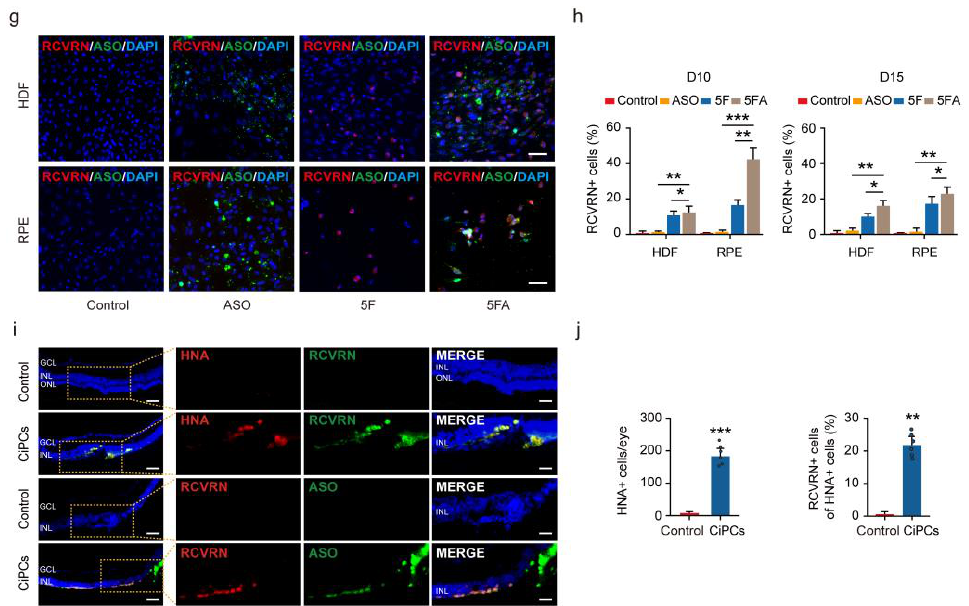
Figure 2. CiPCs induction is enhanced by suppression of PTBP1. ( a , b ) Bright-field images of HDF ( a ) and RPE cells ( b ) treated with PTBP1 ASO only or 5F plus ASO (5FA) at D3 and D10. Scale bars: 50 µ m. ( c ) Relative mRNA expression of PTBP1 after 5F or 5FA treatment at D3 and D10. n = four repetitions. Statistical comparison was performed by a two-tailed, unpaired t-test. ( d ) Western blot analysis showing that the expression of PTBP1 was significantly downregulated after 5FA treatment at D3 and D10. n = three repetitions. ( e , f ) Relative mRNA expression of photoreceptor- related genes in ASO only, 5F, and 5FA treated HDF ( e ) and RPE cells ( f ) versus control at D10. n = four repetitions. Statistical significance was evaluated by one-way ANOVA with a Tukey’s post hoc. ( g ) Immunofluorescence staining of RCVRN on cells treated with ASO, 5F, or 5FA at D10. Nuclei were stained with DAPI. n = four repetitions of each group. Scale bars: 50 µ m. ( h ) Quantification of RCVRN positive staining cells among all DAPI positive cells in different conditions at D10 and D15. Statistical significance was evaluated by two-way ANOVA with a Bonferroni post hoc. ( i ) Representative immunostaining images of CiPCs that survived into the subretinal space, stained for human nuclear antigen (HNA) and expressed the photoreceptor marker RCVRN. The dashed line boxes are magnified on the right side. GCL, ganglion cell layer; INL, inner nuclear layer; ONL, outer nuclear layer. Nuclei were stained with DAPI. Scale bars: left: 50 µ m, right: 25 µ m. ( j ) Quantification of average HNA positive cells per eye and RCVRN positive cells among all HNA positive cells. n = six eyes in each group. Statistical comparison was performed by a two-tailed Mann–Whitney